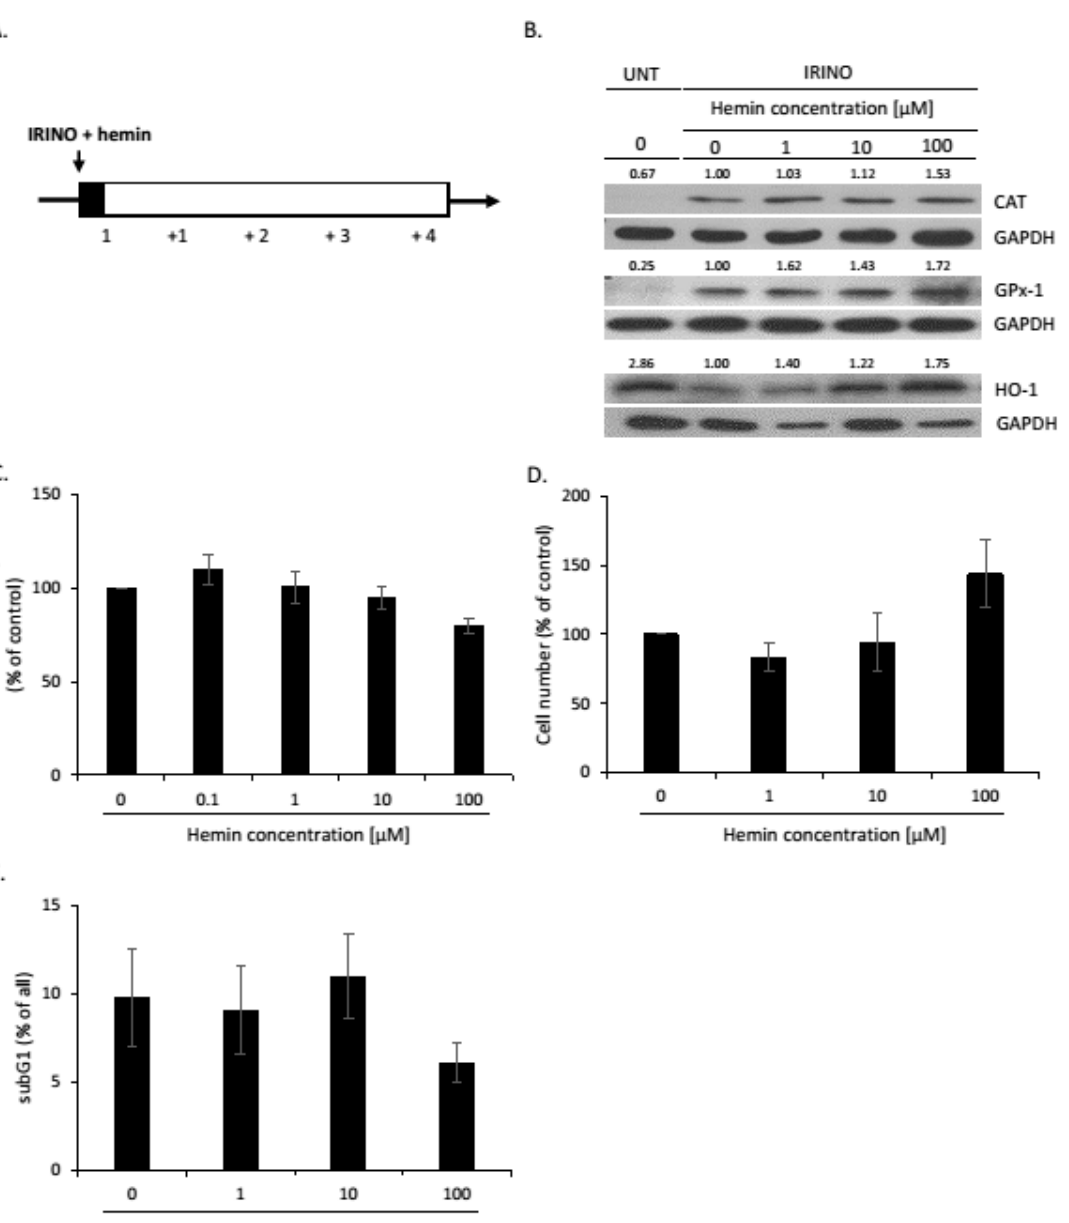
Figure 1. Hemin influences the activity of senescent HCT116 cells. ( A ) The scheme of the experiment. HCT116 colon cancer cells were subjected to 2.5 µM of irinotecan (IRINO) and 1, 10, or 100 µM of hemin. After 24 h, the medium was changed and cells were cultured in a drug-free medium for 4 days. ( B ) Expression of antioxidative enzymes in untreated (UNT) and IRINO-treated cells subjected to hemin in different concentrations. Representative blots show levels of catalase, GPx-1, and HO-1 proteins. GAPDH acts as loading control; ( C ) Evaluation of metabolic activity assayed by MTT assay; ( D ) Evaluation of cell number. Cell number was counted using Bürker’s chamber. ( E ) Quantification of the percentage of cells in the subG1 phase (with DNA content < 2C). Cell cycle analysis was performed with the use of Muse TM Cell Cycle Reagent and flow cytometry. Each bar represents mean ± SEM, n ≥ 3.